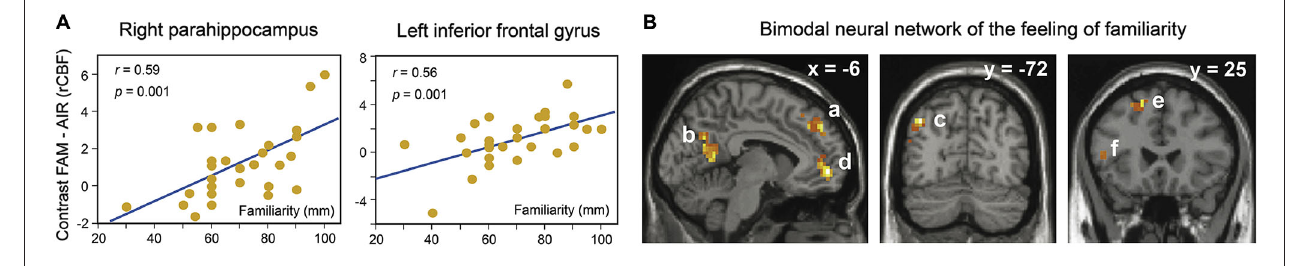
familiarity evoked by odor and music (in comparison with the feeling of unfamiliarity). a, superior frontal gyrus; b, precuneus; c, angular gyrus; d, superior frontal gyrus bordering the cingulate gyrus; e, superior/middle frontal gyrus; f, inferior frontal gyrus. All regions were in the left hemisphere. The hippocampus and parahippocampal gyrus were regions of interests and hence were not displayed (adapted from Plailly et al.,